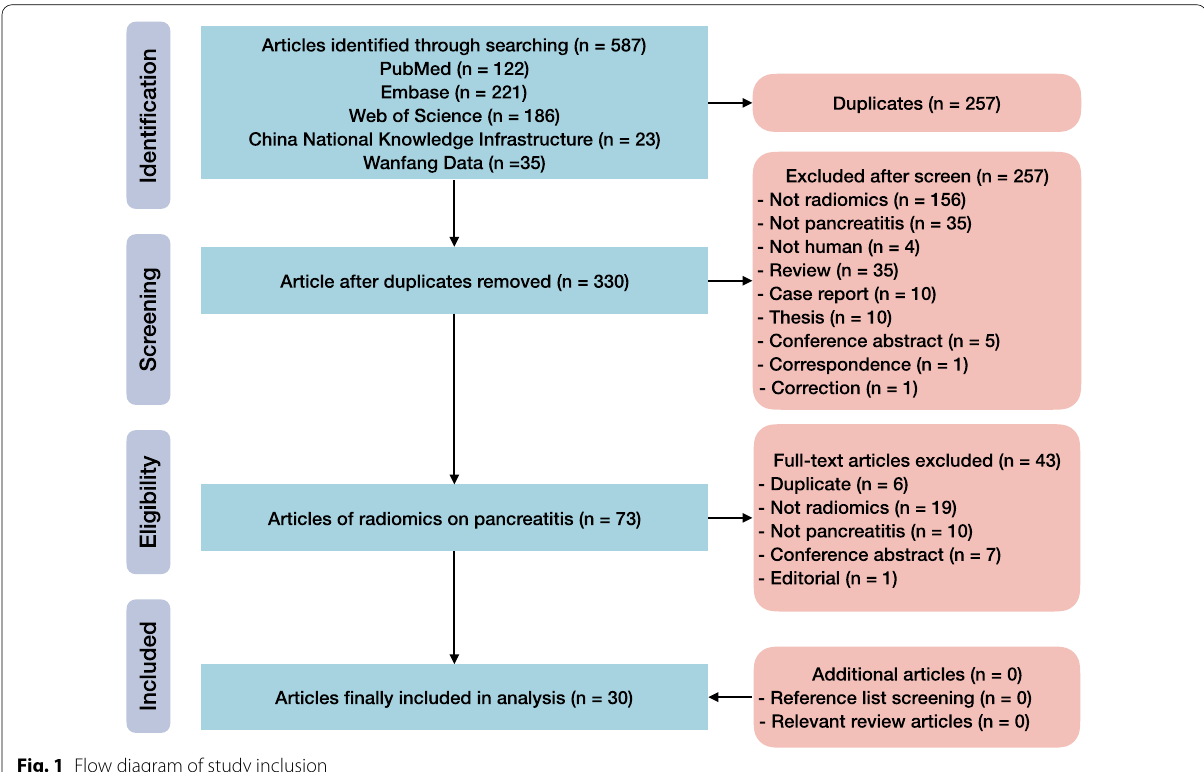
Fig. 1 Flow diagram of study